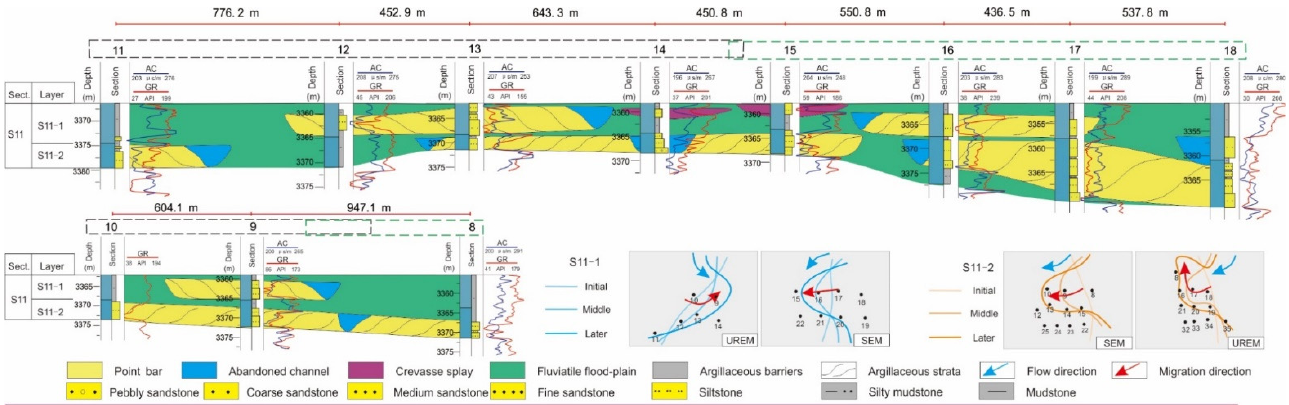
Figure 15. Profile T1 of comprehensive analysis including evolution model of meander bend-based multiple connected core wells which are collected from database in S 11 sublayer of Su-X block, Sulige gas field, Ordos Basin, China: migration areas Z1 (green frame), Z2 (black frame).